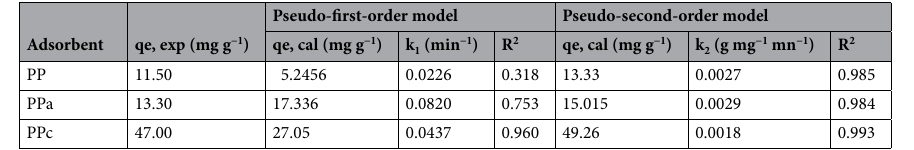
Table 3. Parameters of kinetic equations for the adsorption of CB onto PP, PPa and PPc.